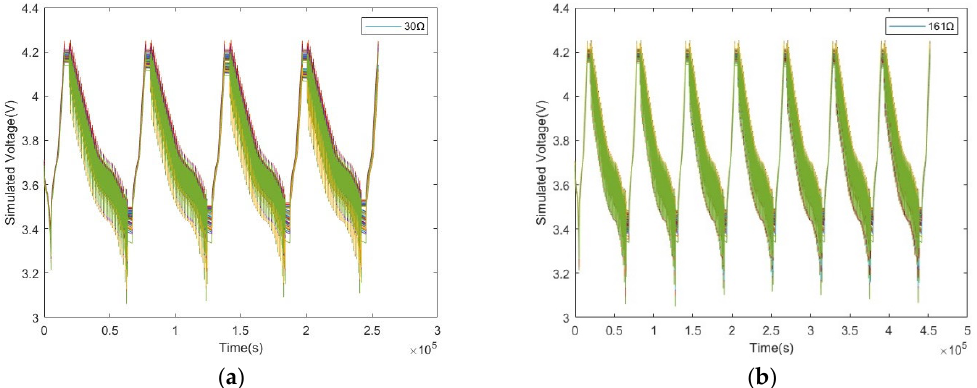
Figure 4. Simulated voltage curve of ISC. ( a ) ISC resistance of 30 Ω ; ( b ) ISC resistance of 161 Ω .